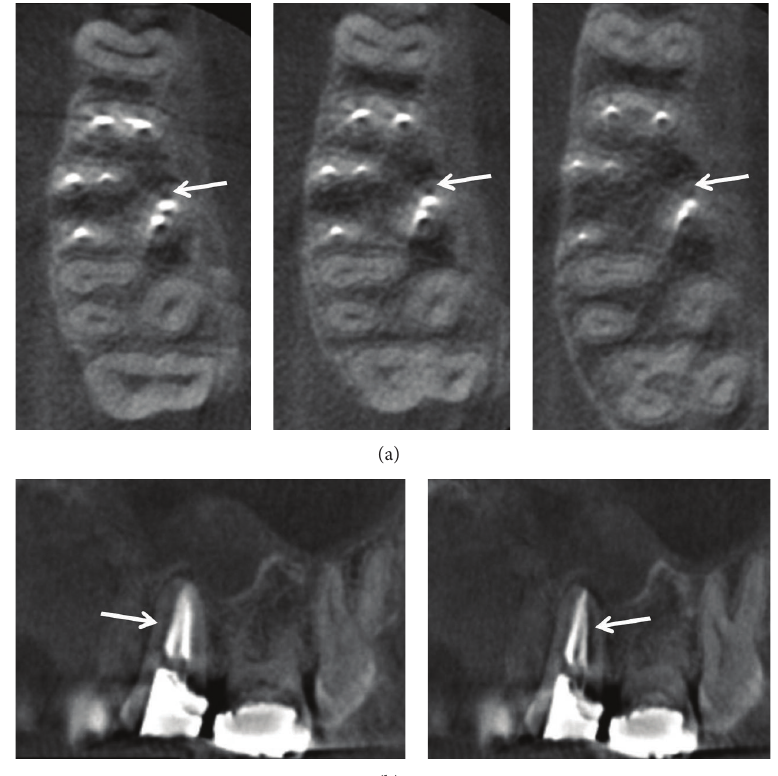
Figure 2: (a) From left to right, axial scans of coronal, middle, and apical root sections suggesting the presence of a third root canal in the palatal root (arrows). (b) Sagittal scans demonstrating that the third canal observed at previous images was an artifact (arrows). Note the presence of hypodense periapical areas on the palatal